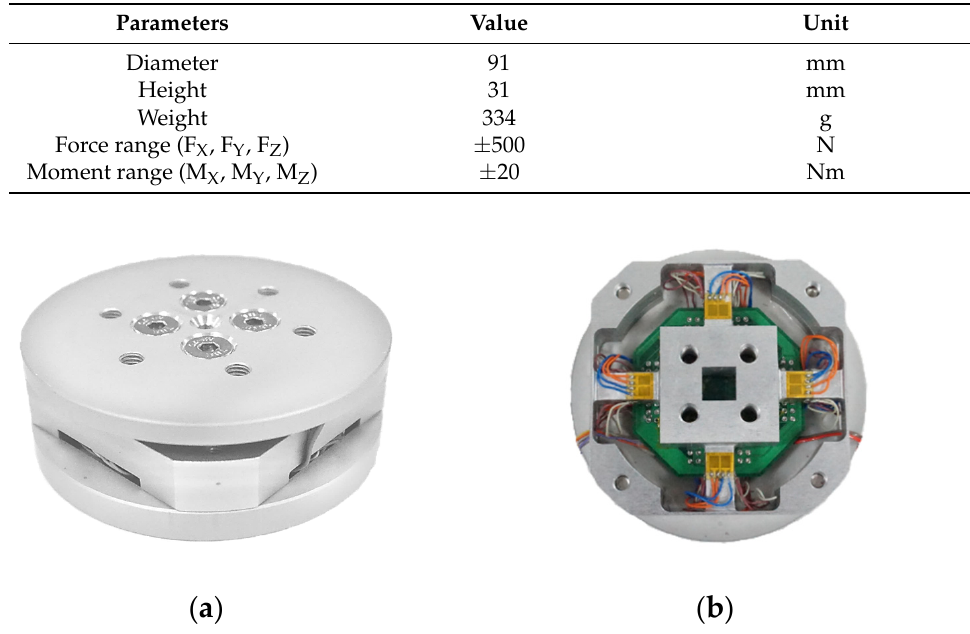
Figure 1. ( a ) Six-Axis F/M sensor assembled. ( b ) Elastic body of six-axis F/M sensor. Table 1. Structural design specification.